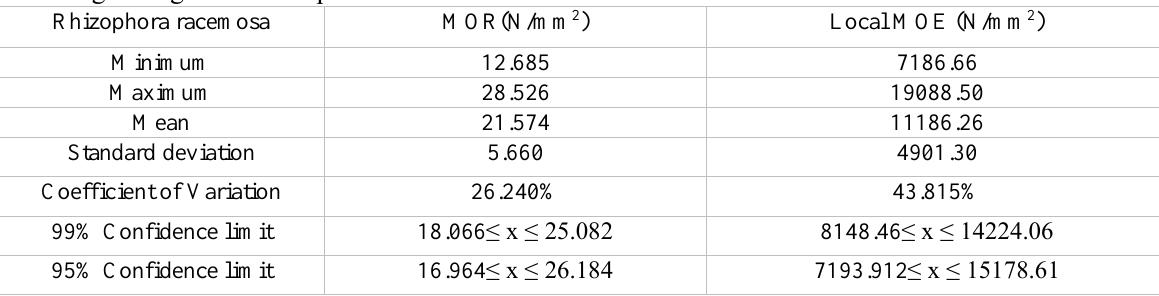
Bending Strength for Rhizophora racemosa Timber.